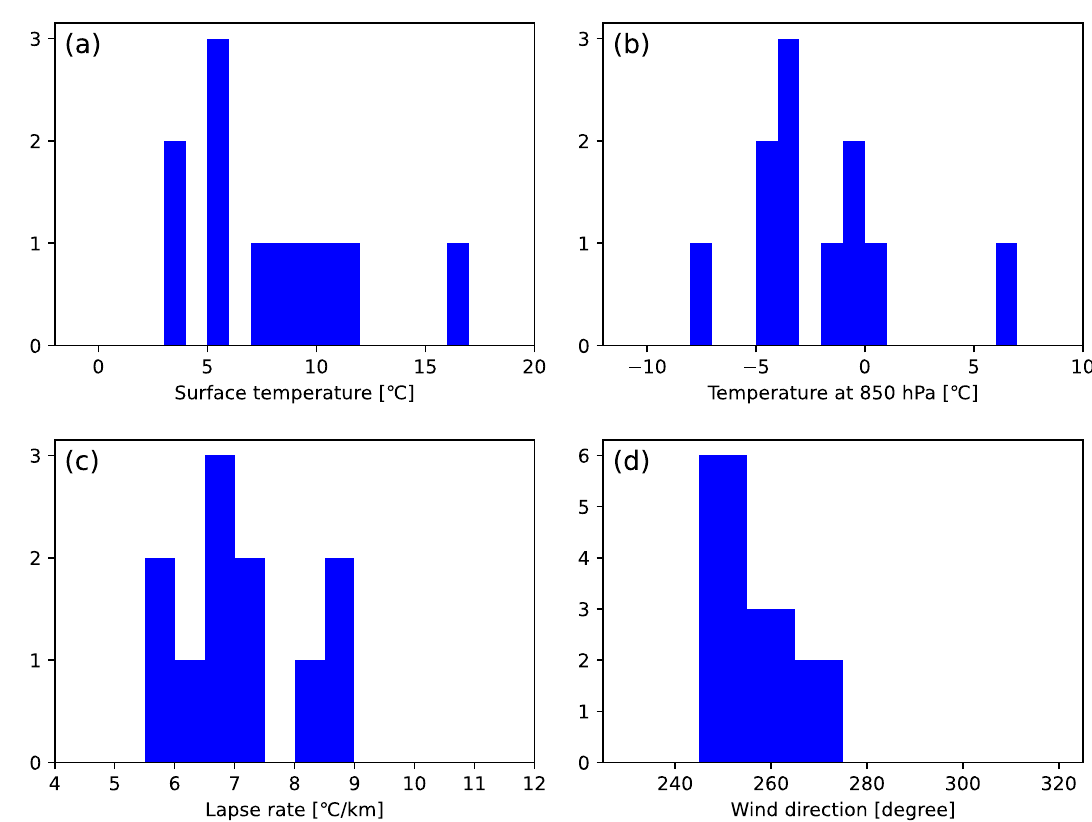
Fig. 11 Histograms of meteorological parameters in the non-detection cases, presented in the same format as Fig.